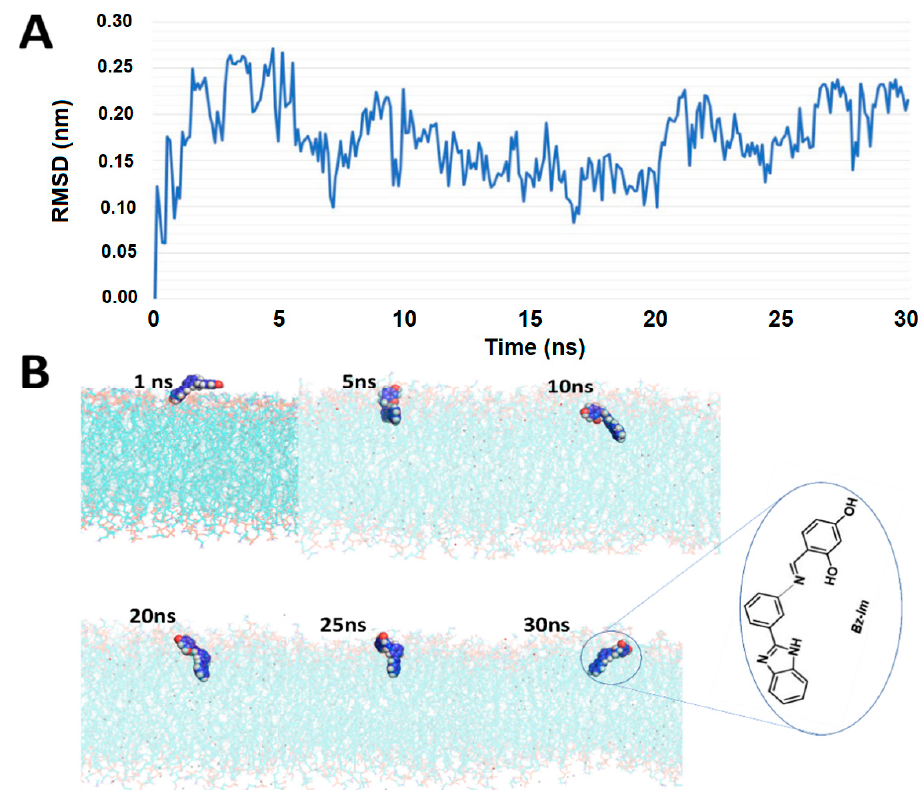
Figure 4. Behavior of Bz-Im in the E. coli membrane model system for 30 ns. ( A ) Root mean square deviation (RMSD) of Bz-Im in the E. coli membrane model system for 30 ns. ( B ) Bz-Im movement from the surface of the E. coli membrane model system during the 30 ns.